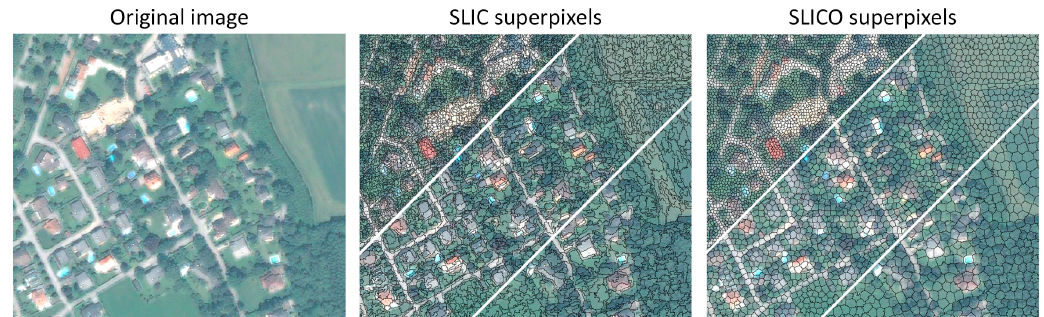
Figure 11. Visual comparison of superpixels produced by SLIC and SLICO methods, on a subset of T2. The average superpixel size in the upper left of the image is 5 × 5 pixels, in the middle of the image is 10 × 10 pixels and 15 × 15 pixels in the lower right.